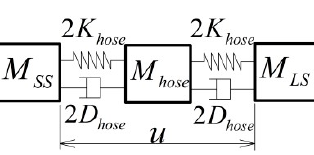
Figure 3. The mass–spring–damper model of vacuum hose.